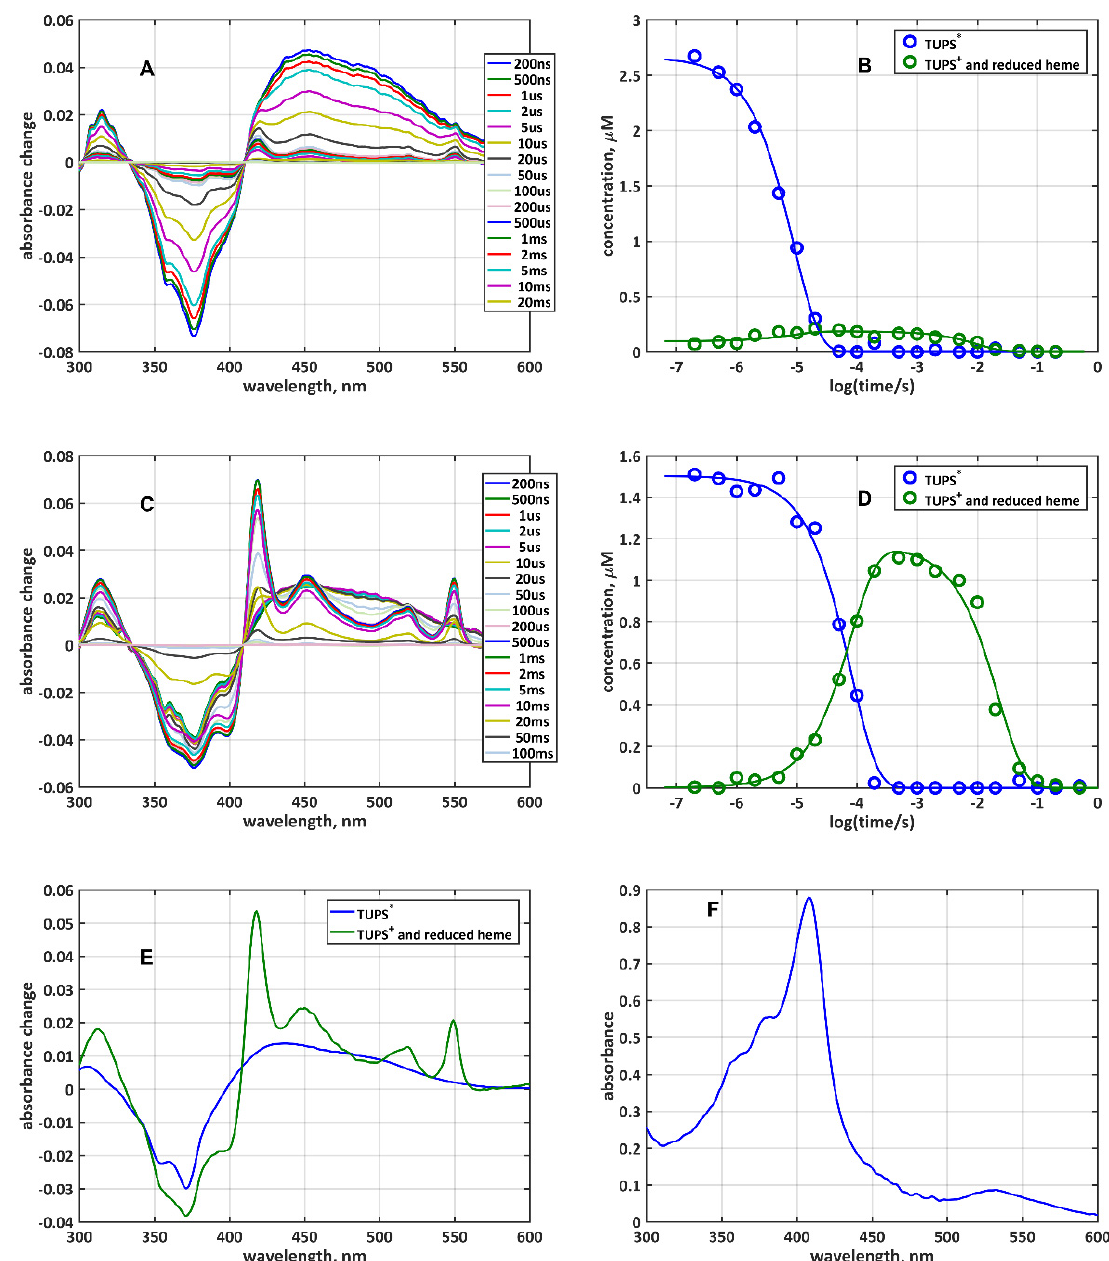
Figure 2. Kinetics of electron transfer between the dye and the heme in G23C-TUPS: Time-resolved difference spectra after laser flash excitation in the presence ( A ) and absence ( C ) of oxygen; ( B , D ) time-dependent concentrations of the {TUPS T* + heme ox } and the {TUPS + + heme red } species (symbols) and fit to Scheme 1 (lines). The rate coefficients obtained from the fit are: k quench = 1.10 × 10 5 , k forward = 3.84 × 10 3 , and k reverse = 97.5 s − 1 in the presence of O 2 , and k quench = 2.84 × 10 3 , k forward = 9.58 × 10 3 , and k reverse = 43.7 s − 1 in anaerobiosis; ( E ) base difference spectra used for the least-squares fit of the spectra in ( A ) and ( C ); ( F ) absorption spectrum of the G23C-TUPS sample before photoexcitation, with fully oxidized heme and characteristic TUPS bands in the 350–390 nm